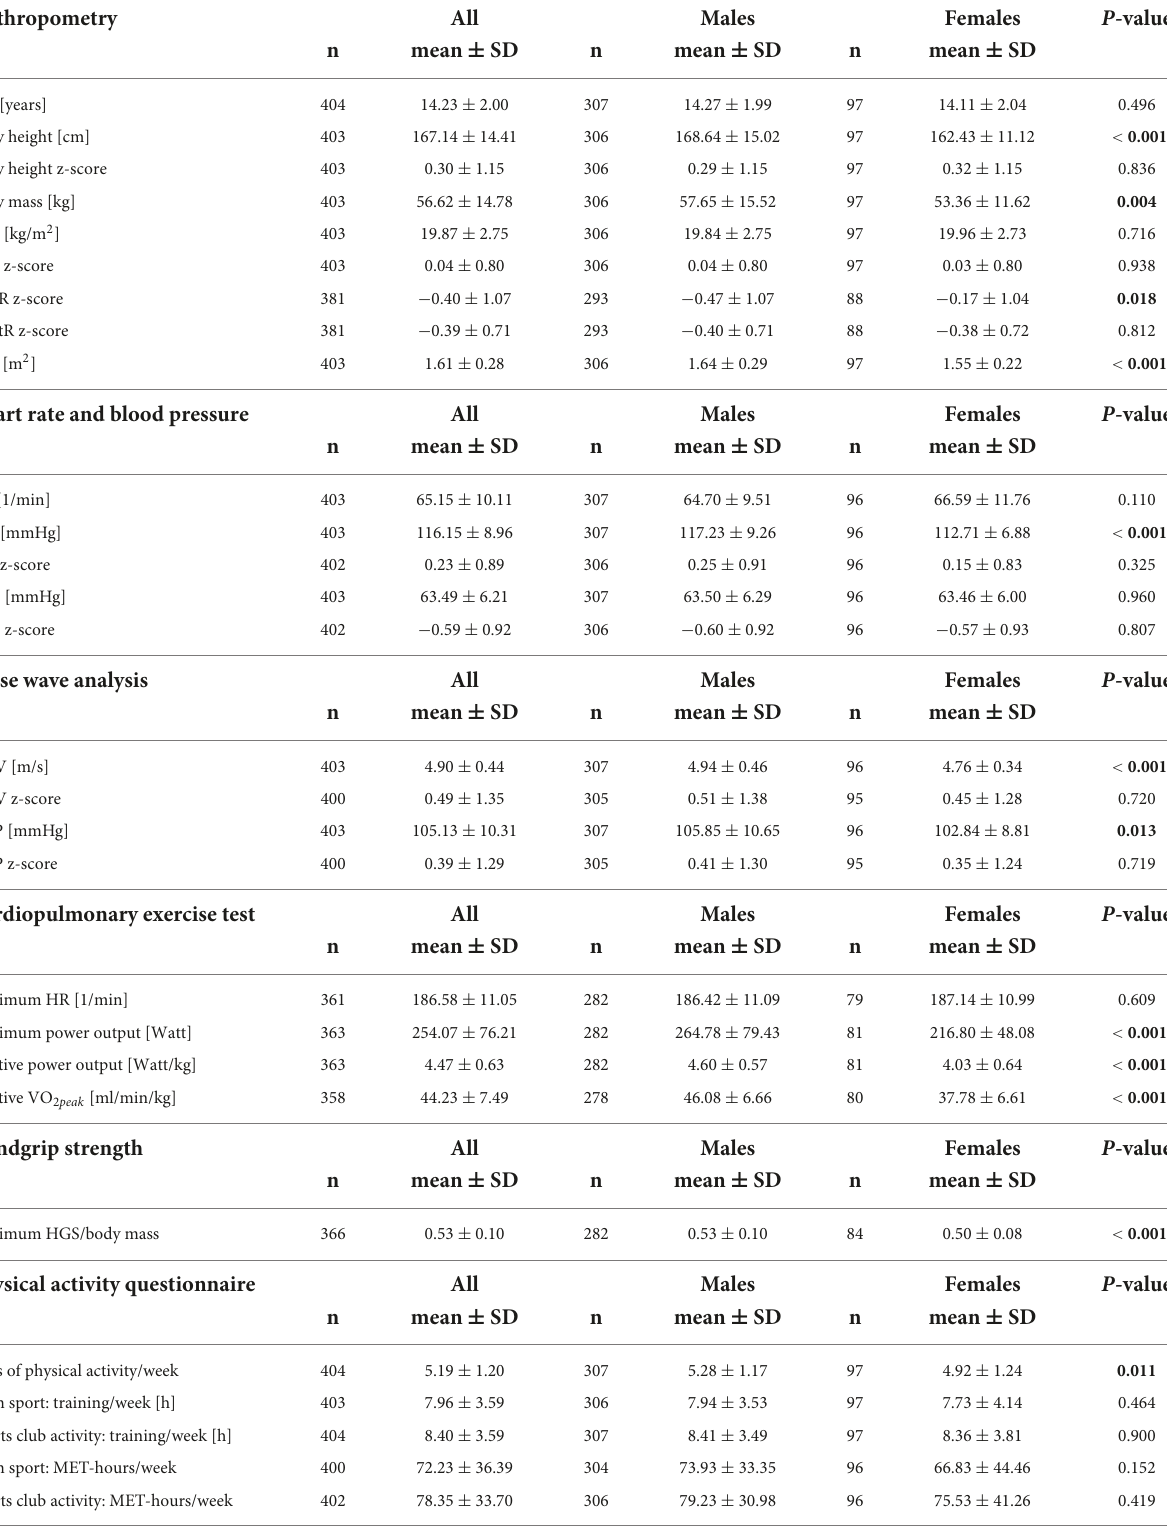
TABLE 1 Participants’ anthropometric characteristics, data on heart rate, blood pressure, and pulse wave analysis, as well as data on physical performance and training time. Anthropometry